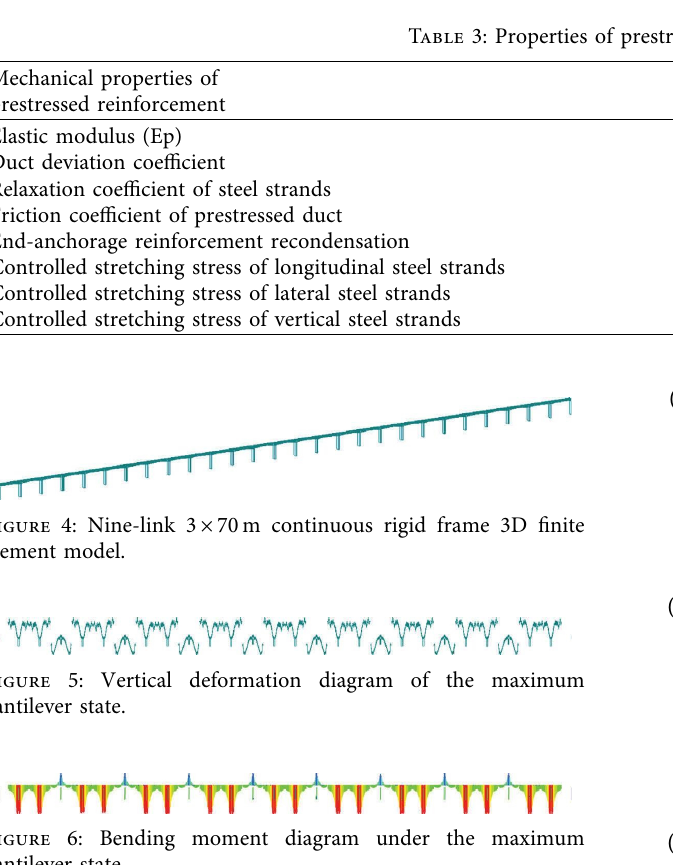
Figure 6: Bending moment diagram under the maximum cantilever